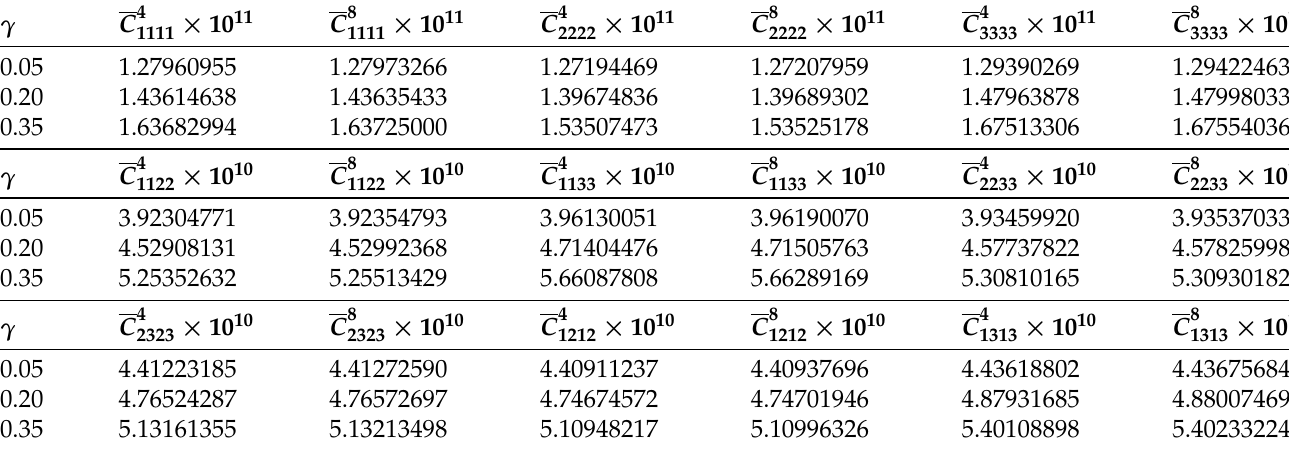
Table 6. Calculated effective elastic coefficients for the Nicalon/BMAS composite material formed by elliptical cross- section fibers.